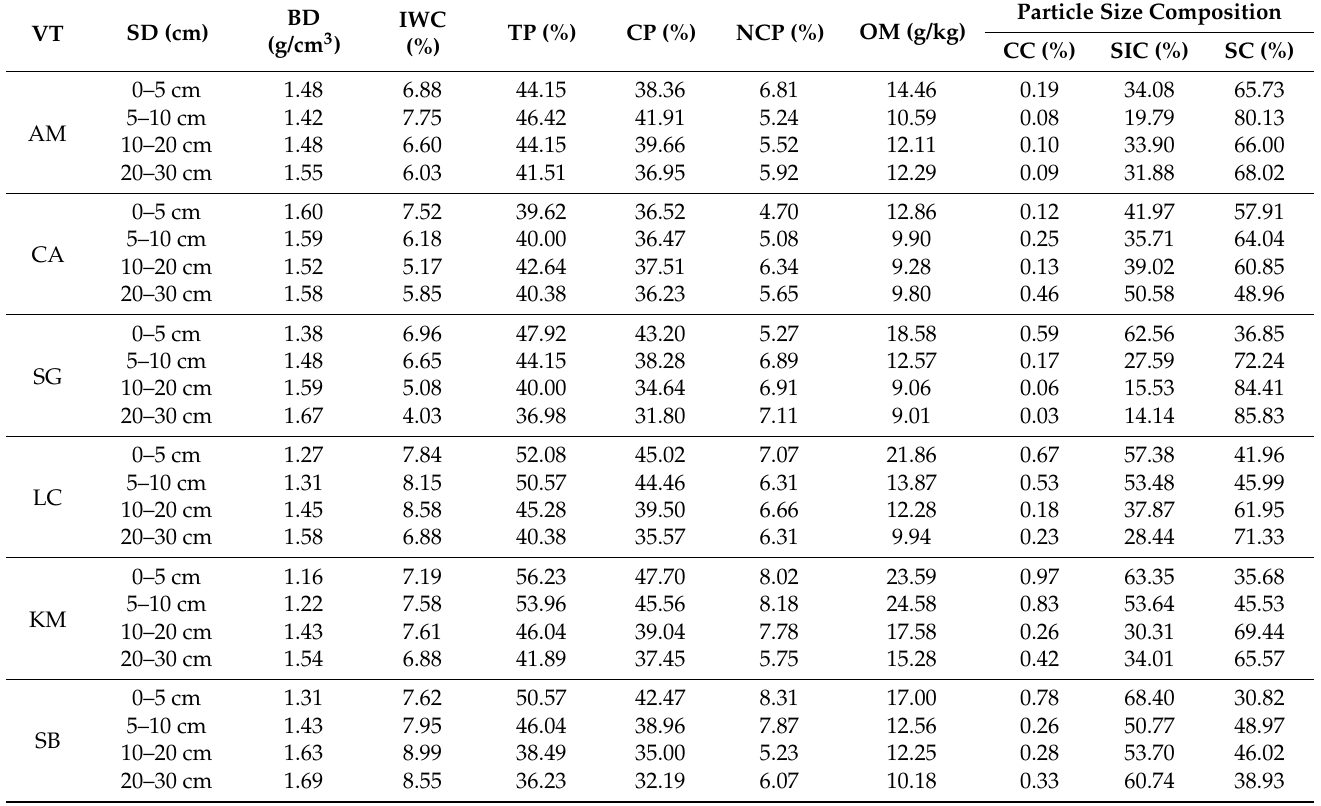
Table 2. Soil characteristics of different